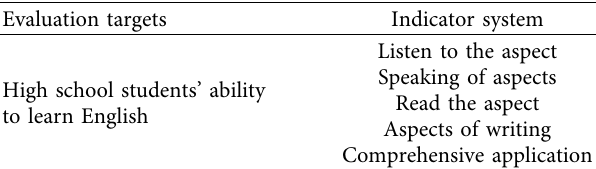
Table 4: Table of English learning ability evaluation index system for high school